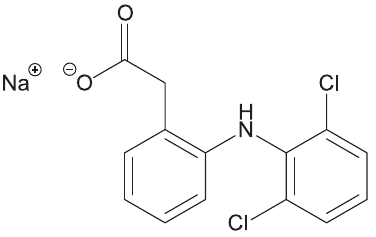
FIGURA 1 - Chemical structure of diclofenac